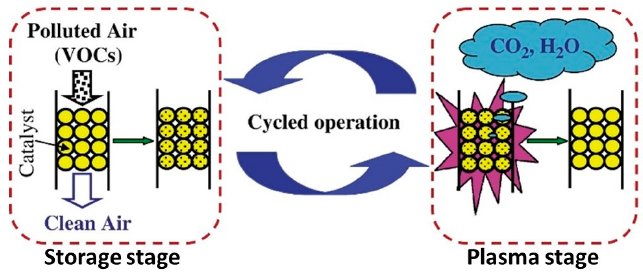
Figure 2. The working principle of the cyclic adsorption–plasma catalytic process for VOC removal. Reprinted from Reference [44], with permission from Elsevier.